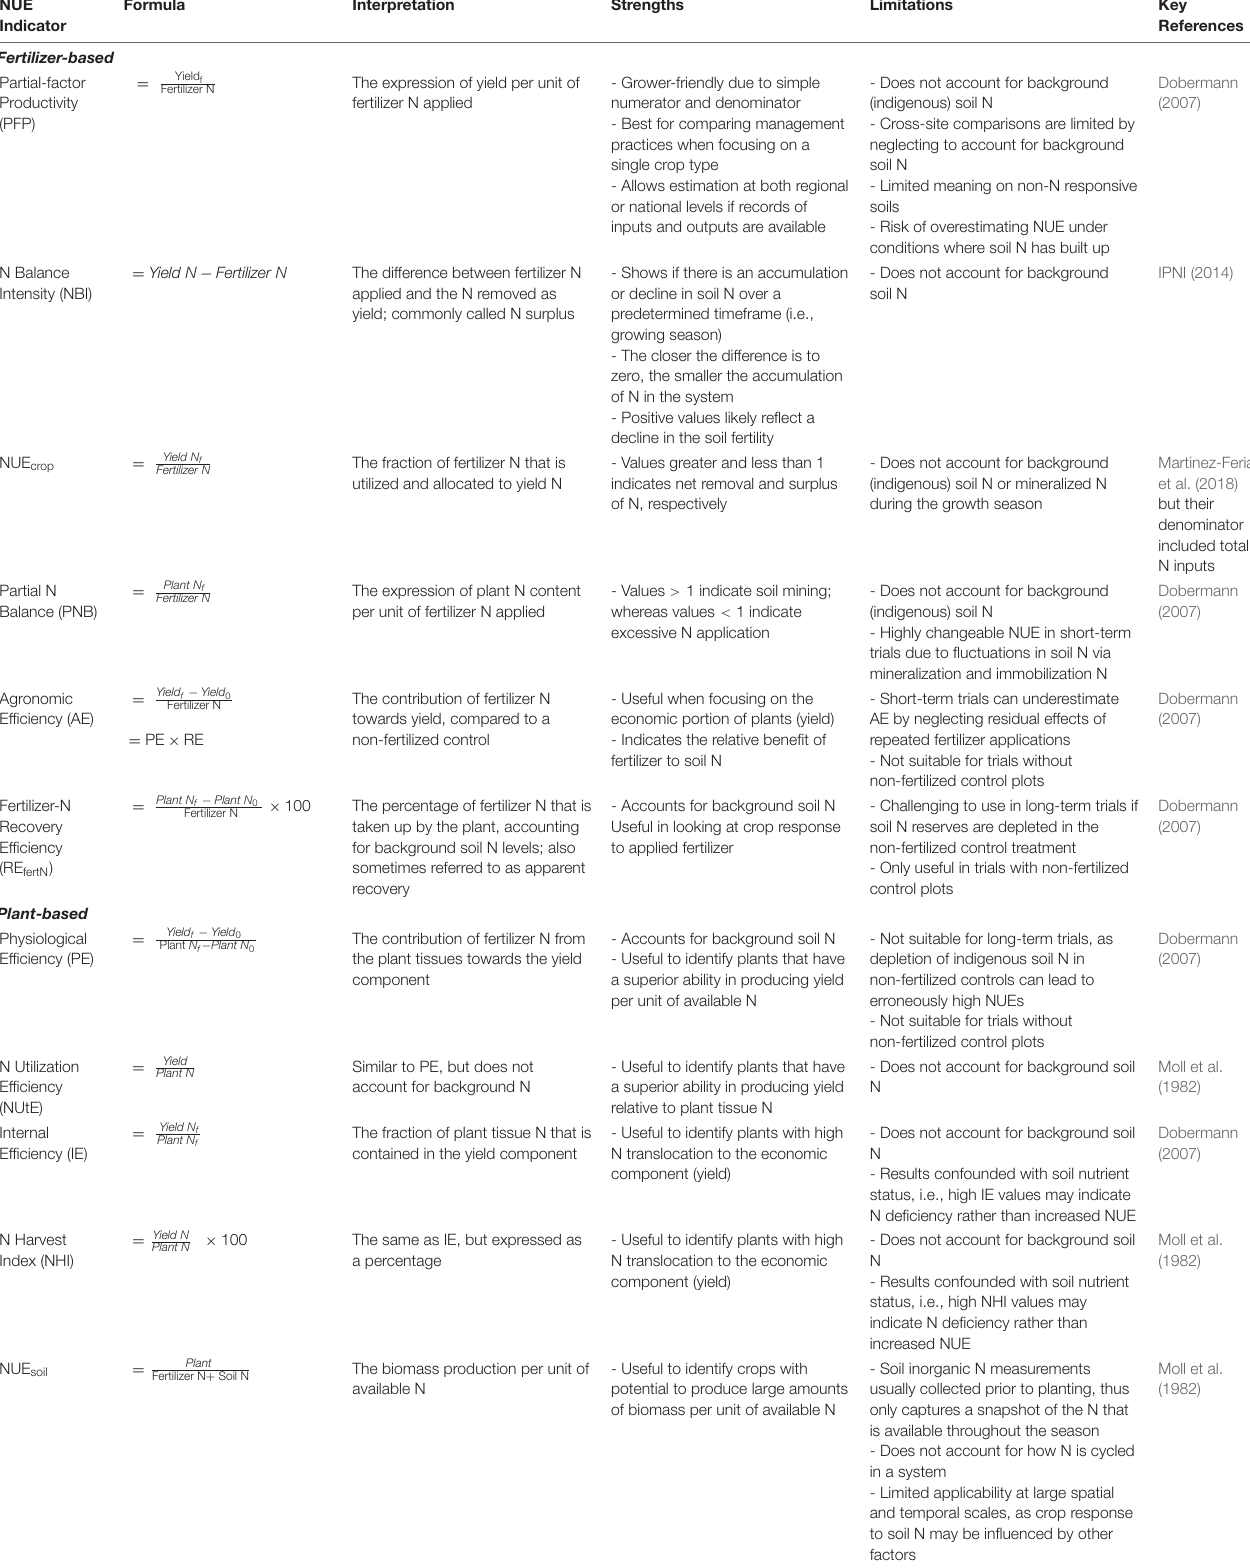
TABLE 1 | Various NUE indices and their associated formulae a , interpretation, strengths, and